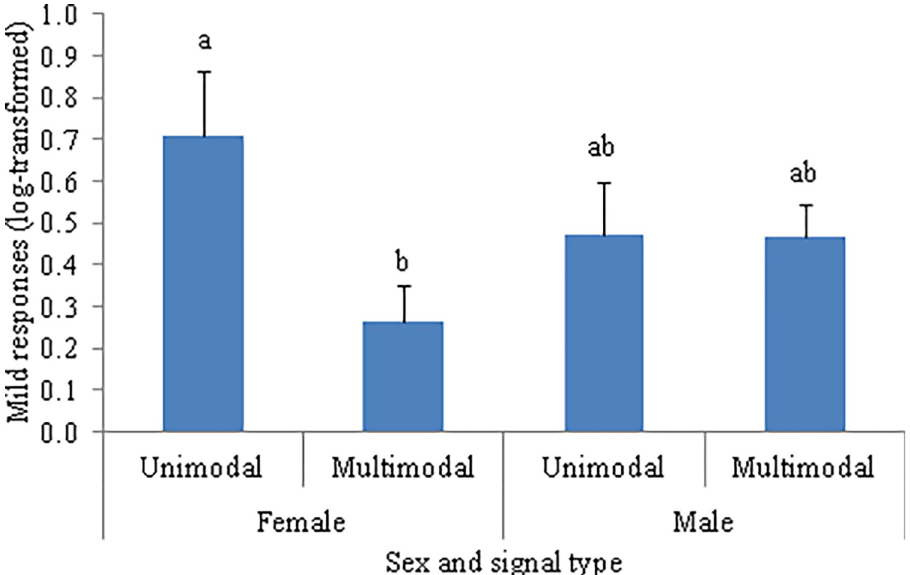
Fig 10. Mean (log-transformed) number of occurrences of non-aggressive responses to unimodal and multimodal signals. The female and male white-lipped peccaries were displaying submissive behaviors. Error bars denote SE of means. Different letters above bars represent a significant difference ( P < 0.05).